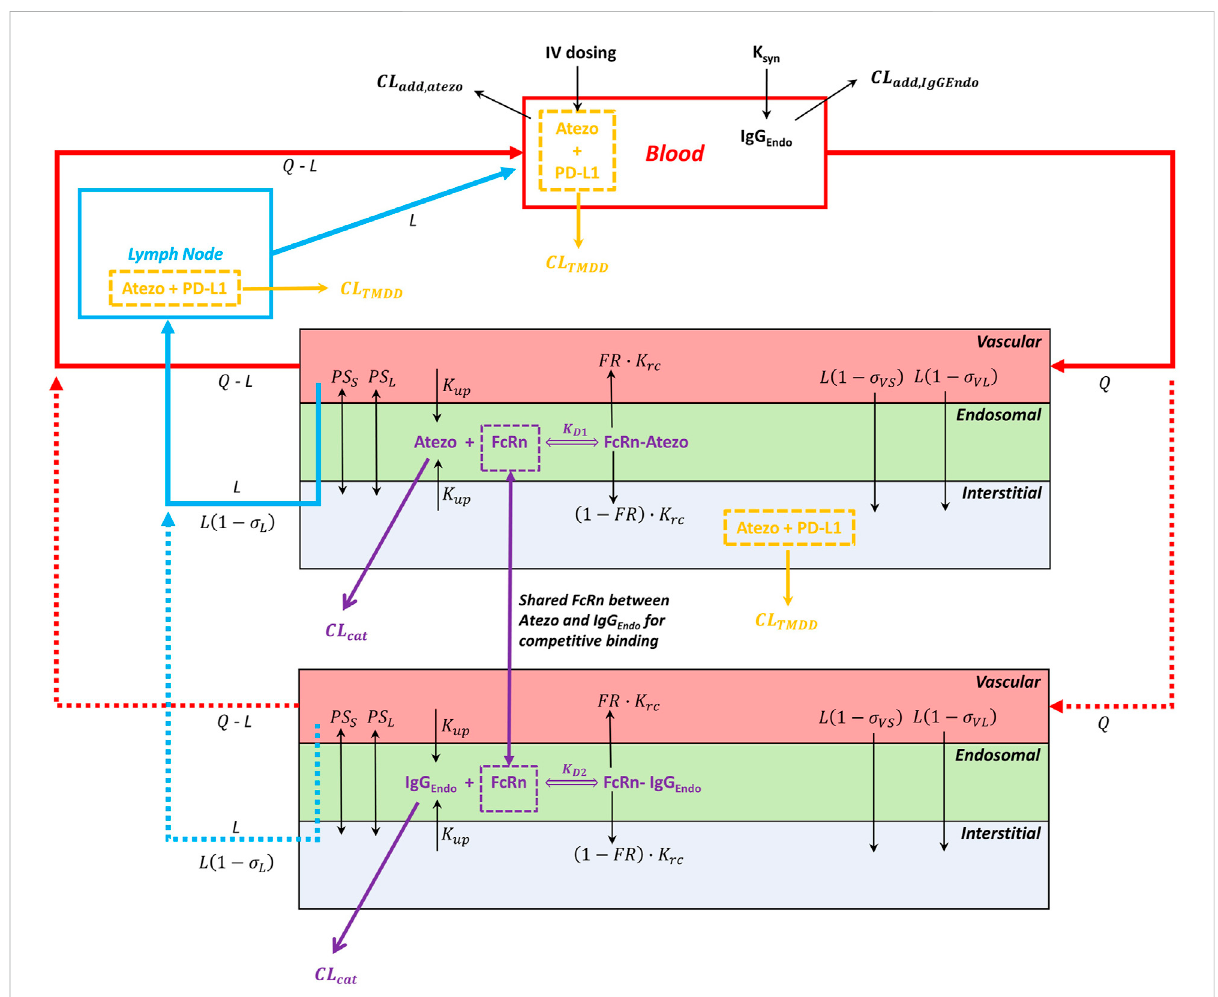
FIGURE 1 Minimal PBPK model structure and key mechanisms for atezolizumab disposition. The model consists of the blood, lymph node, and lumped tissue compartments. The lumped tissue includes vascular, endosomal, interstitial, and intracellular (not shown) compartments. The 1: 1 atezolizumab-FcRn binding at pH 6.0 in the endosomal compartment was considered. The additional clearance (CL add ) is included in the blood compartment.TheTMDDisincludedinthebloodcompartment,thelymphnodecompartment,andtheinterstitialcompartmentofthelumped tissue. Abbreviations for model parameters are as follows: CL add , atezo , additional clearance for atezolizumab; CL add,IgG,endo , additional clearance for endogenous IgG; CL TMDD , clearance for atezolizumab via binding to the target PD-L1; CL cat , the intrinsic catabolic clearance of atezolizumab or endogenous IgG that are not bound to FcRn; FcRn, neonatal Fc receptor; K D1 , equilibrium dissociation constant for atezolizumab-FcRn complex; K D2 , equilibriumdissociation constant for endogenous IgG-FcRn complex;K rc ,endosomalrecyclingrate;K up ,endosomal uptakerate via fl uidphase endocytosis; FR, fraction recycled of FcRn-bound atezolizumab or endogenous IgG; PS s , permeability surface area product for small pores; PS l , permeability surface area product for large pores; σ vs , vascular re fl ection coef fi cient through small pores; σ vl , vascular re fl ection coef fi cient through large pores;